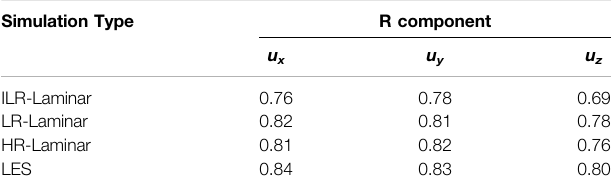
TABLE 4 | Pearson correlation coef fi cients (R) for the three components of velocity, calculated using the entire aortic fl uid domain. R is calculated using instantaneous velocities in ILR-Laminar, and phase-averaged velocities in LR-, HR-Laminar and LES.